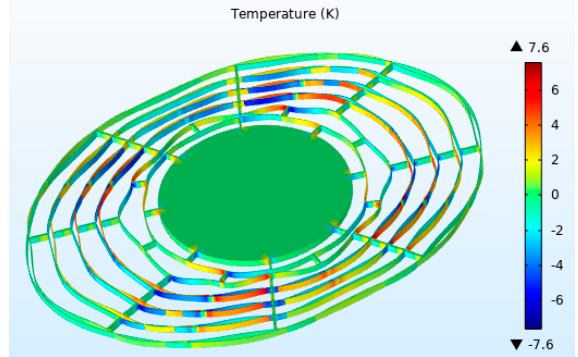
Figure 4. Temperature variation with respect to the reference temperature (298 K) for the n = 2 wineglass mode of the vibrating ring.